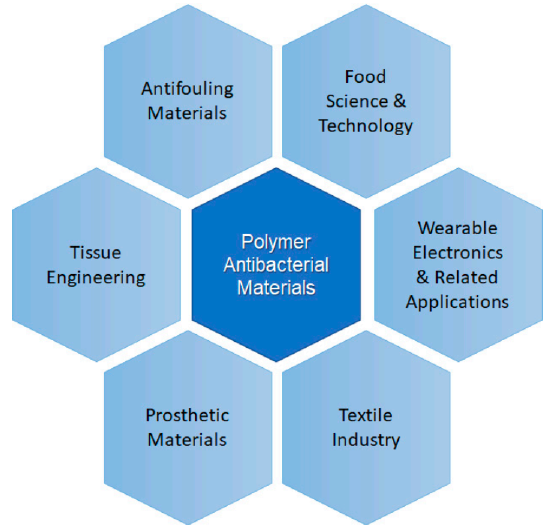
Figure 1. Scheme illustrating some areas of application of polymer antibacterial materials.